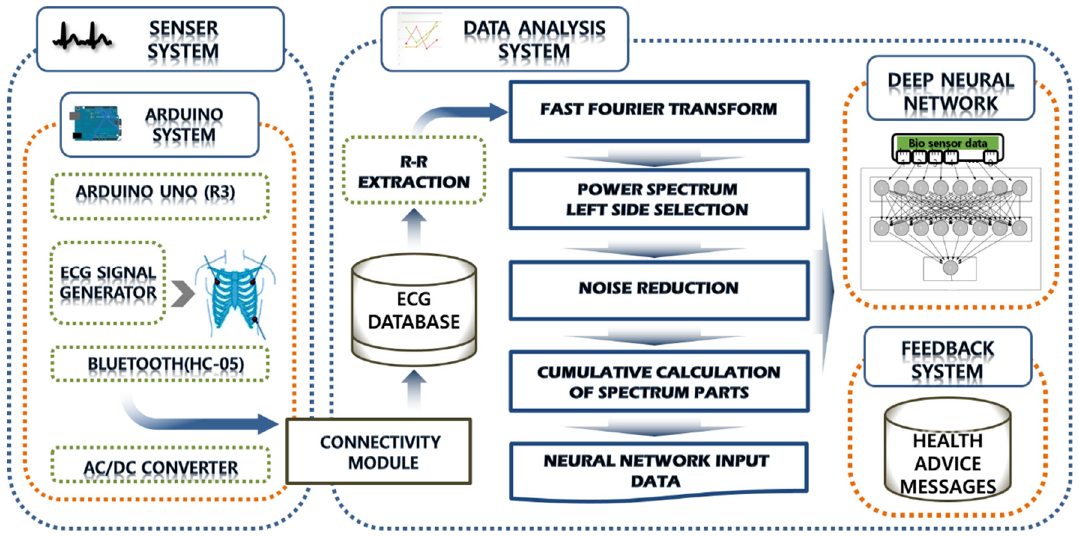
Figure 6. Structure of terminal models including the bioinformation collection module.